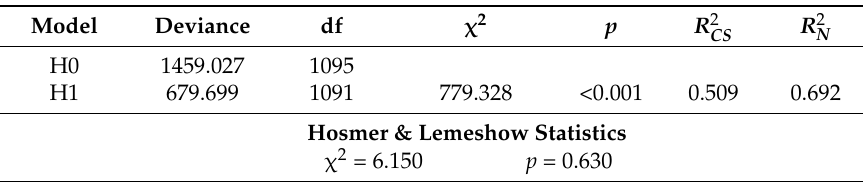
Table 2. Model Summary.